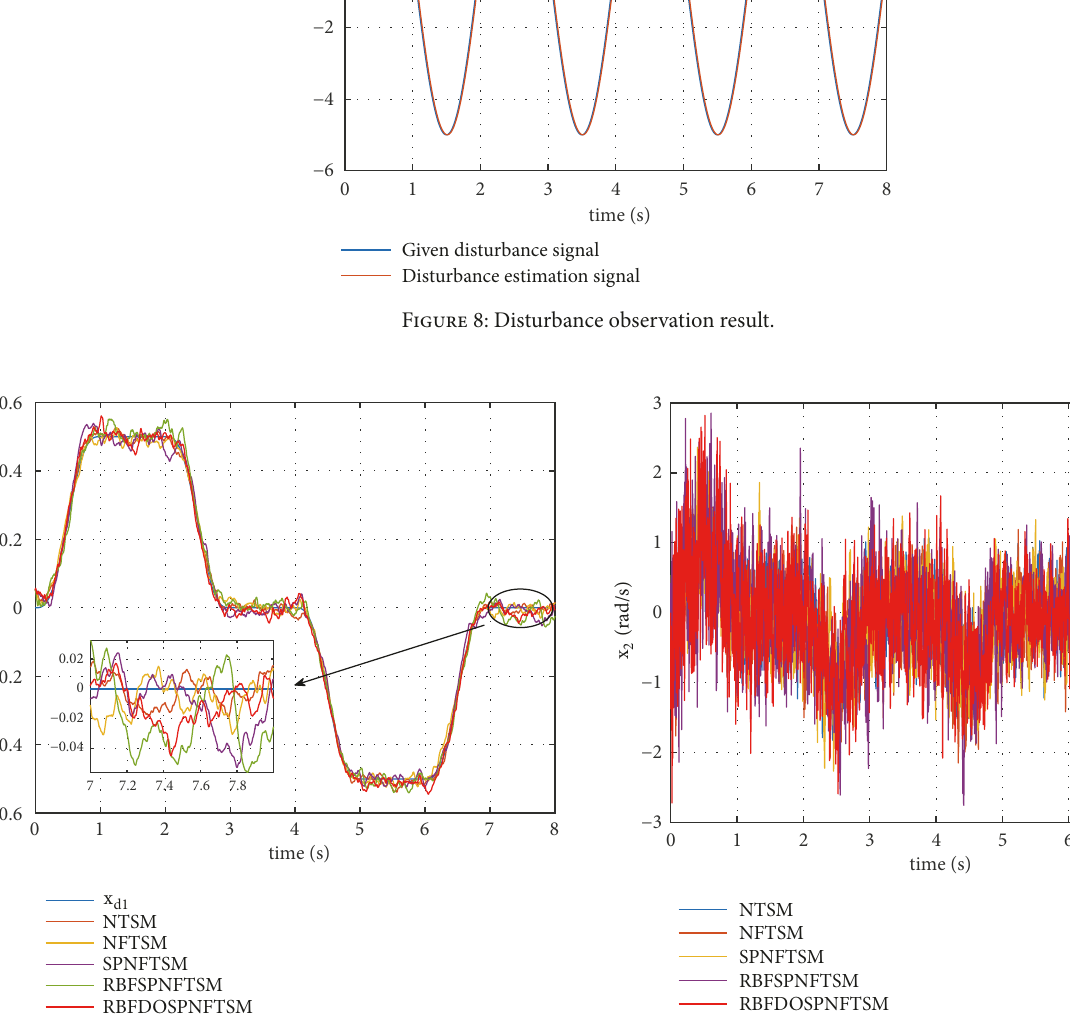
Figure 9: Swing angle tracking curve (adding noise). Figure 10: Swing speed response curve (adding